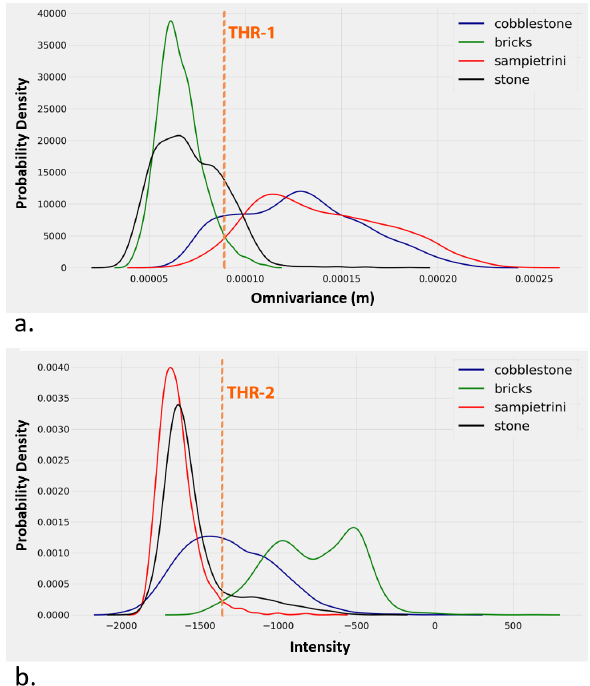
Figure 4. Cumulative probability density functions of several samples of the 4 materials analysed. a: Omnivariance, computed with a spherical neighbours with a radius of 5 centimetres. b: measured Intensity of the returning signal of the laser scanner.